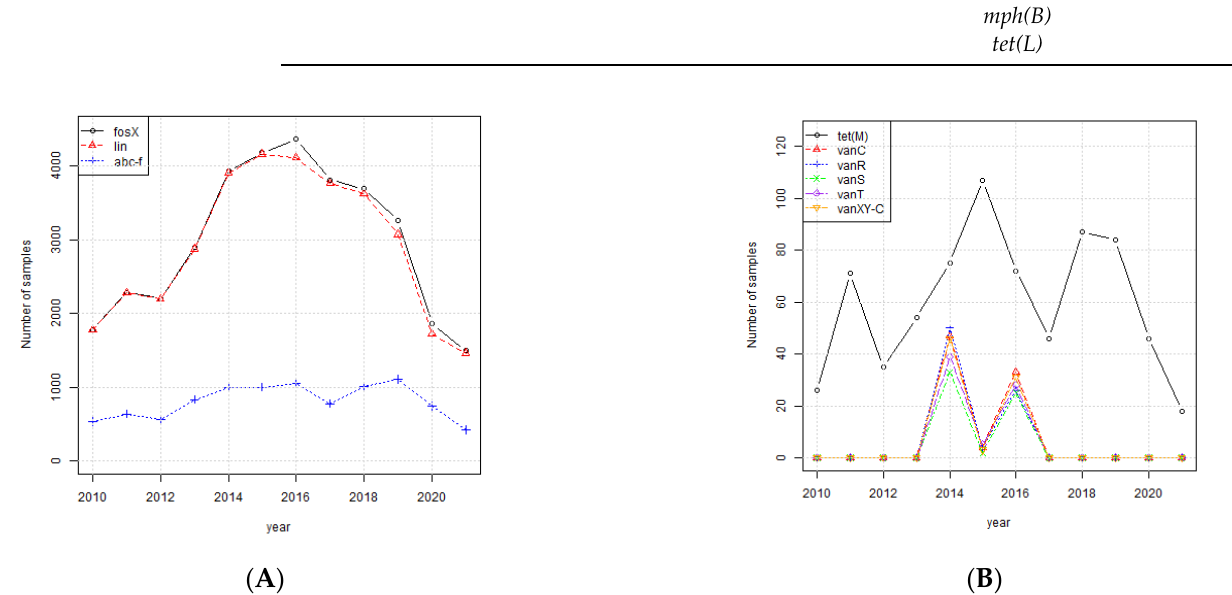
Figure 6. ( A ) Number of L. monocytogenes samples per year with genes fosX , lin, and abc-f and tet(M) . ( B ) Number of L. monocytogenes samples per year with genes vanC , vanR , van S, vanT , and vanXY-C.